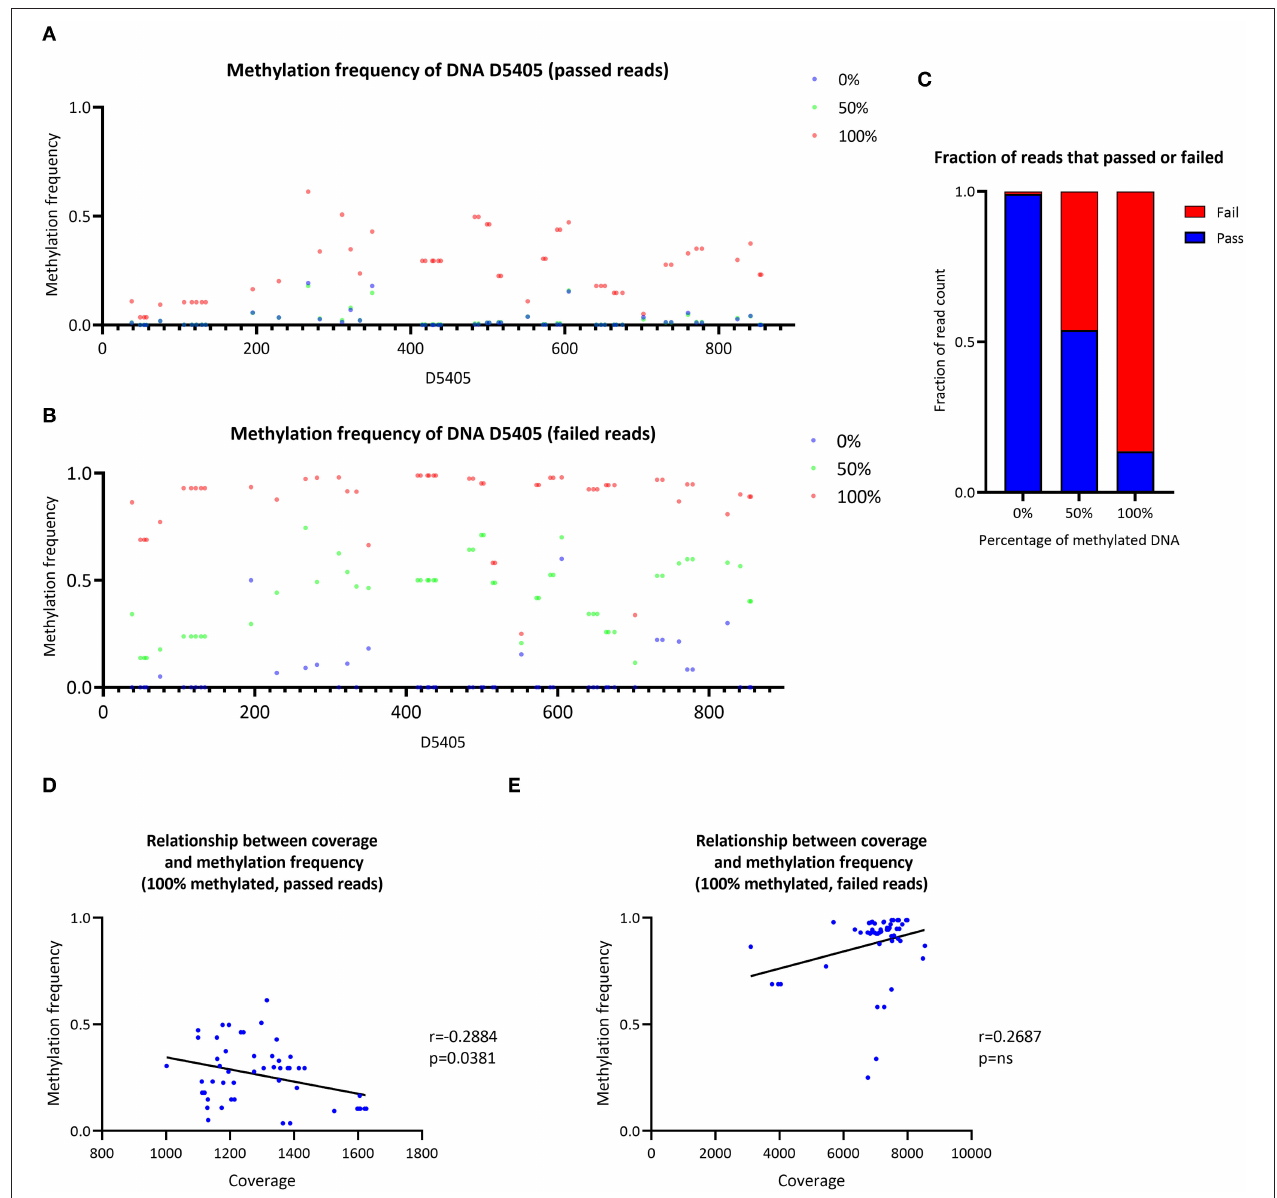
FIGURE 4 | Analysis of synthetic DNA for the validation of the data analysis pipeline. (A) Methylation frequency detected by Nanopolish from three samples of synthetic DNA with different proportions of methylated DNA (0, 50 and 100%), only reads that passed Guppy quality threshold were included in the analysis. (B) Methylation frequency detected by Nanopolish from three samples of synthetic DNA with different proportions of methylated DNA (0, 50 and 100%), only reads that failed Guppy quality threshold were included in the analysis. (C) Stacked bar plot of the fraction of reads that passed (blue) or failed (red) the Guppy quality threshold, stratified by the ratio of methylated reads in the sample. (D) Relationship between the coverage and methylation frequency in the sample with 100% methylated reads, only reads that passed Guppy quality threshold were included in the analysis. (E) Relationship between the coverage and methylation frequency in the sample with 100% methylated reads, only reads that failed Guppy quality threshold were included in the analysis. r, Spearman’s rank correlation coefficient; p, Spearman’s exploratory p -value.